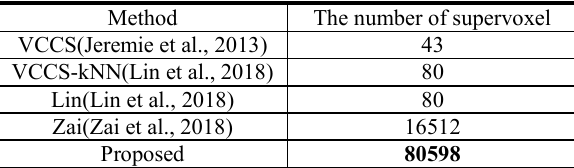
Table 3. The supervoxel information on Semantic3D